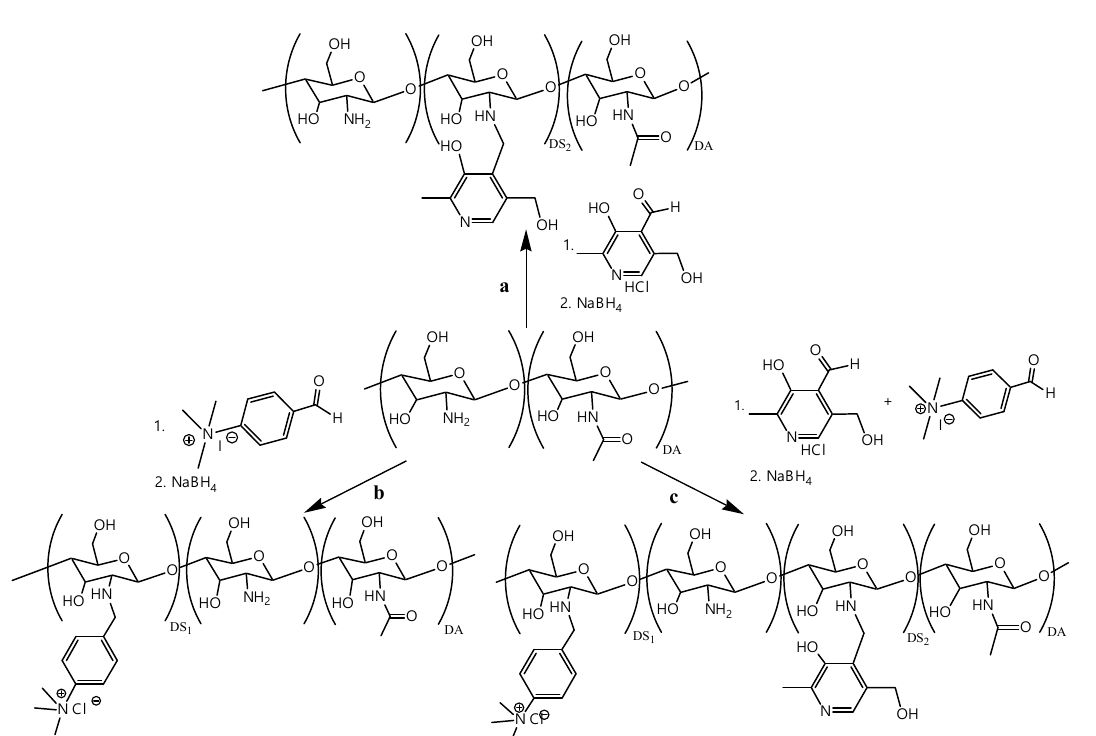
Figure 1. Synthesis scheme for N -[(3-hydroxy-5-(hydroxymethyl)-2-methyl-4-pyridine)methyl]chitosan chloride (Pyr-CS) ( a ), N -[4-( N ’, N ’, N ’-trimethylammonium)benzyl]chitosan chloride (TMAB-CS) ( b ), and N -[4-( N ’, N ’, N ’-trimethylammonium)benzyl]- N -[(3-hydroxy-5-(hydroxymethyl)-2-methyl-4-pyridine)methyl]chitosan chloride (PyrTMAB-CS) ( c ).